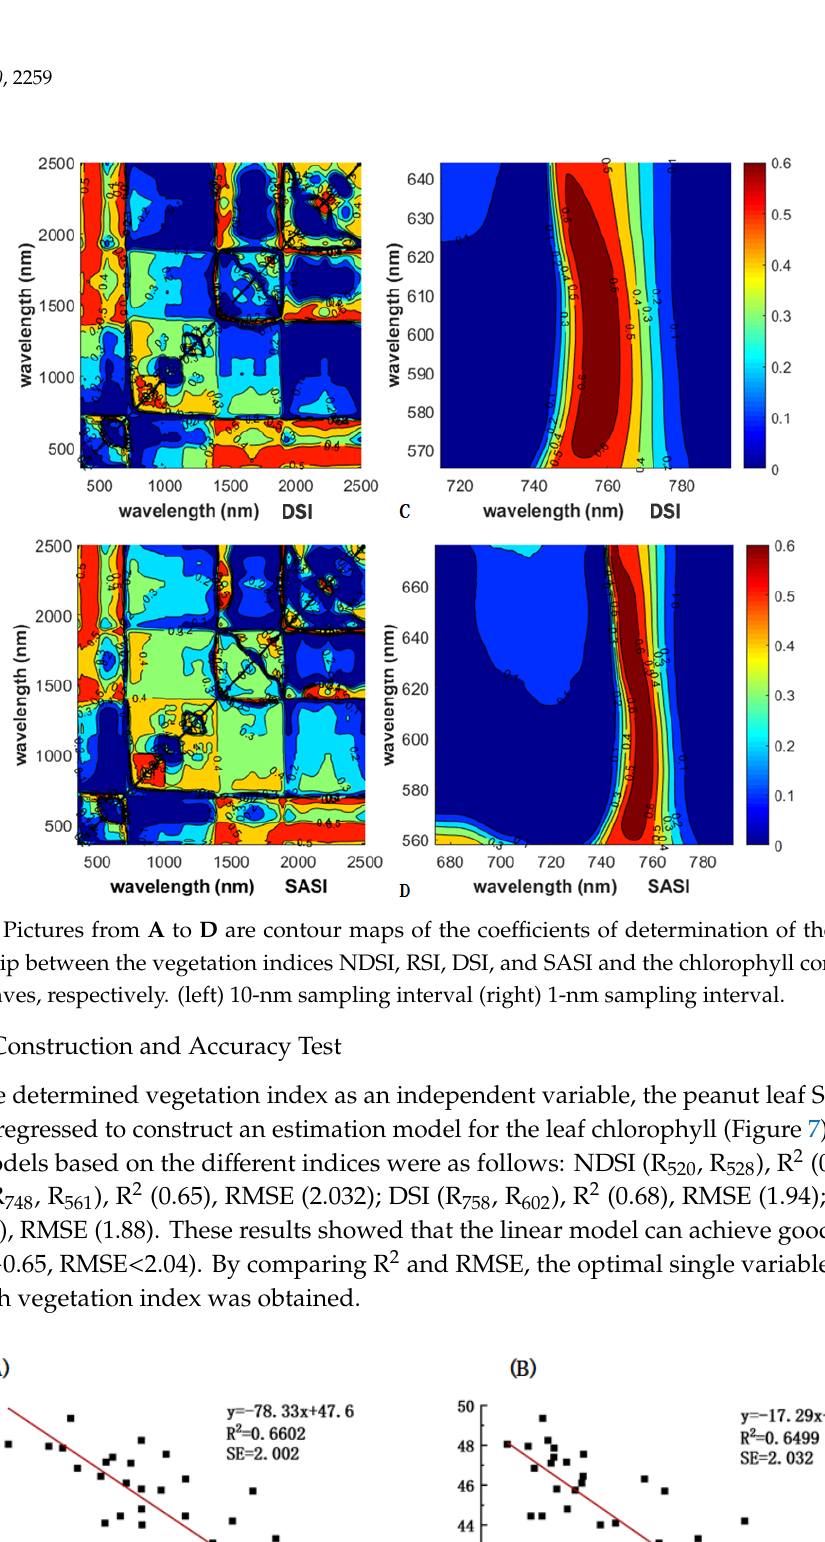
Figure 7. Pictures from A to D show the linear regression of vegetation indices NDSI, RSI, DSI, and SASI with chlorophyll content in peanut leaves respectively. 4. Discussion Peanut is an important cash crop, with an important role in ensuring food supply and security. How to improve its yield per unit area has been a constant focus of peanut research. Traditional cultivation methods aiming to ensure peanut production and emergence rates have set excessive seeding densities, resulting in decreases in peanut yield. Seeding density is not only related to the physiological form of the plant, but also affects crop yield. Some studies have suggested that low- density peanut planting facilitates good growth and chlorophyll content, while high-density planting results in poor growth and a decrease in the overall photosynthetic performance of leaves [ 25 ]. In contrast, a low planting density creates a large light-receiving area per individual plant, which is